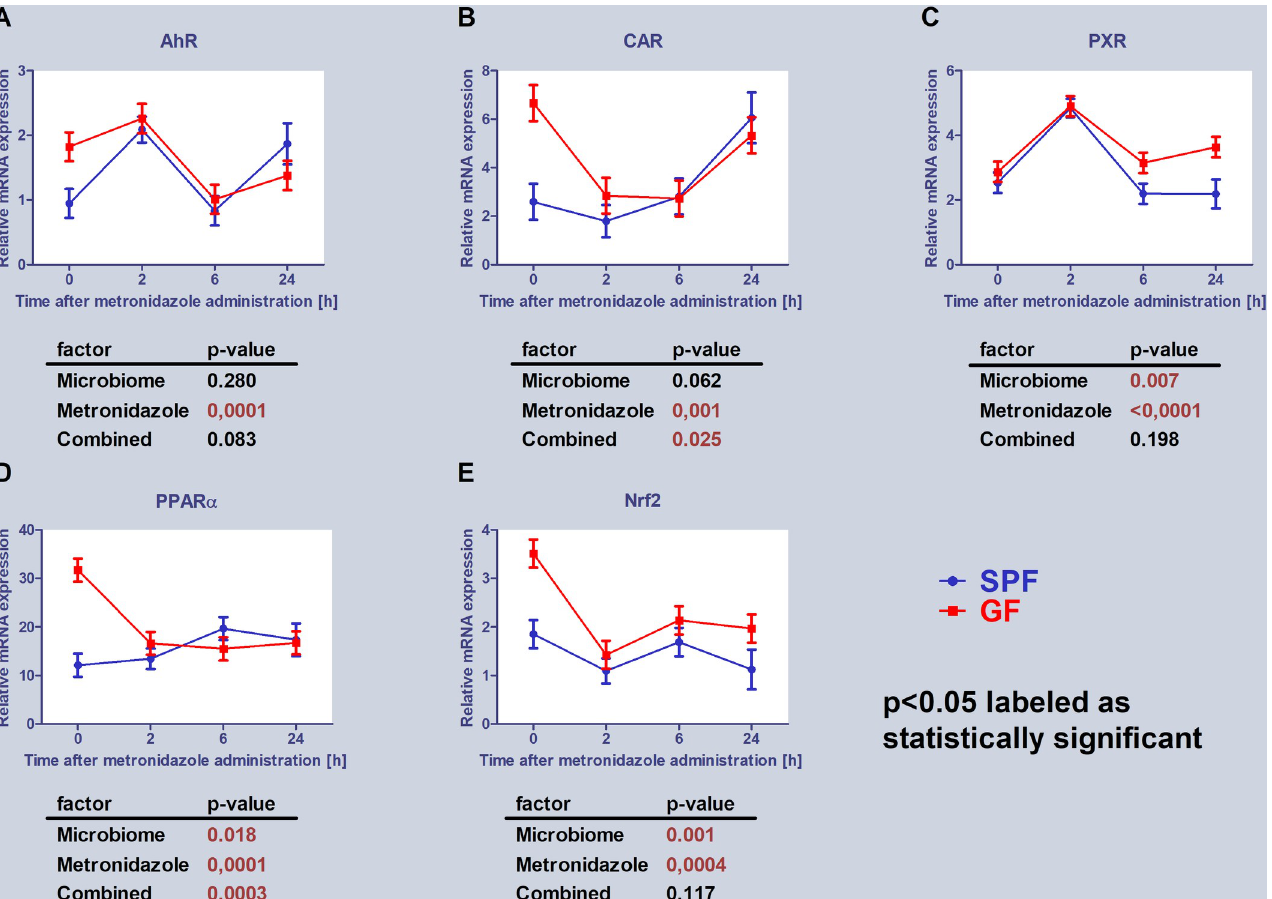
Fig 3. Expression of transcription factors. Comparison of estimated marginal mean values of mRNA expression of selected transcriptional factors in relation with microbiome presence and metronidazole administration in mice liver. The data represent the mean ± SEM from 4 individual animals. The statistical significance was determined using two-way ANOVA and p-values for the effect of microbiome (i.e., difference between SPF and GF groups), metronidazole administration and combined effect of the both are shown in the tables below the respective graphs. Significantly different from control p < 0.05.